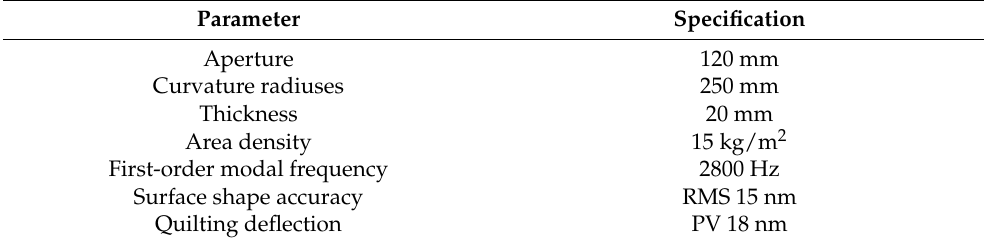
Table 2. Design requirements of the